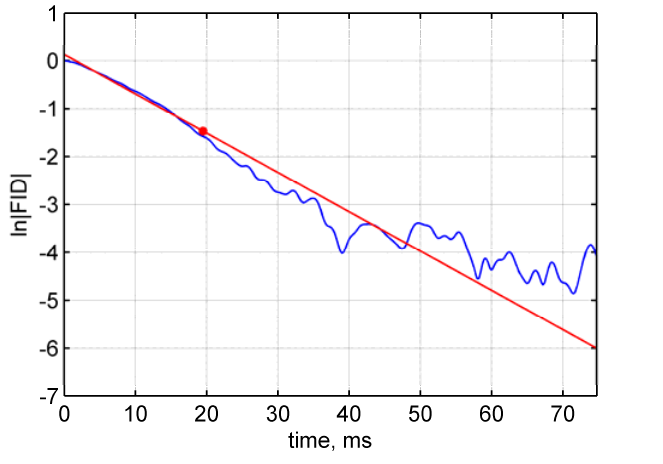
2. Figure 2, p. 1552 should be with the correct time axis. The l Figure 2. Linear regression of FID data. The linear regression fit (red) is exemplarily shown for a VC fSVPS single voxel ln(FID) data (blue) and its optimal linearization length (red dot; l = 19.7 ms, t = 19.12, p < optim